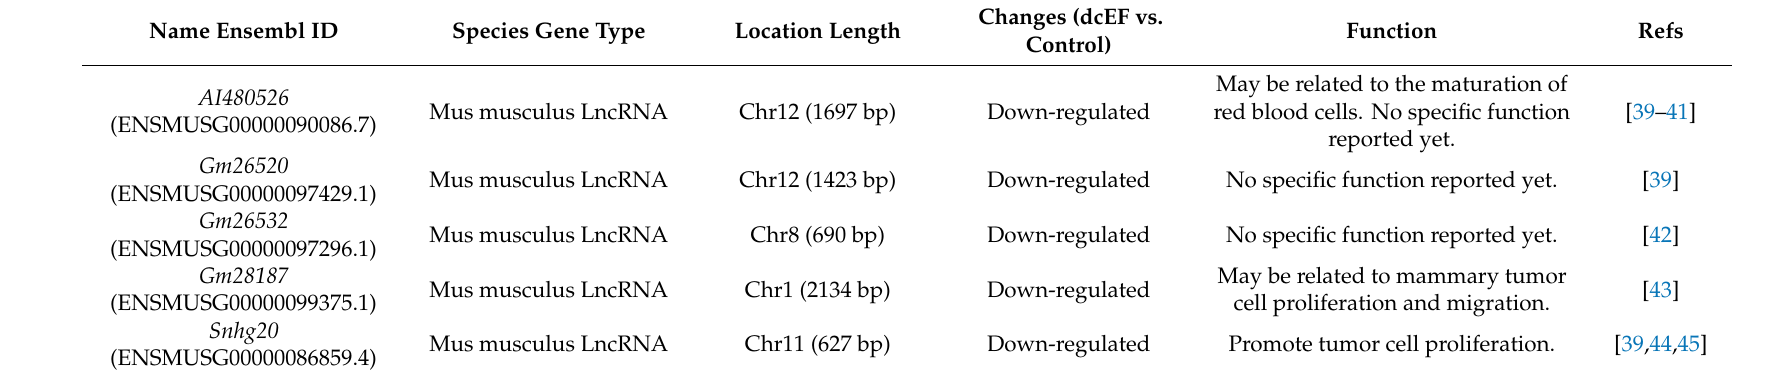
Table 7. dcEF-sensitive